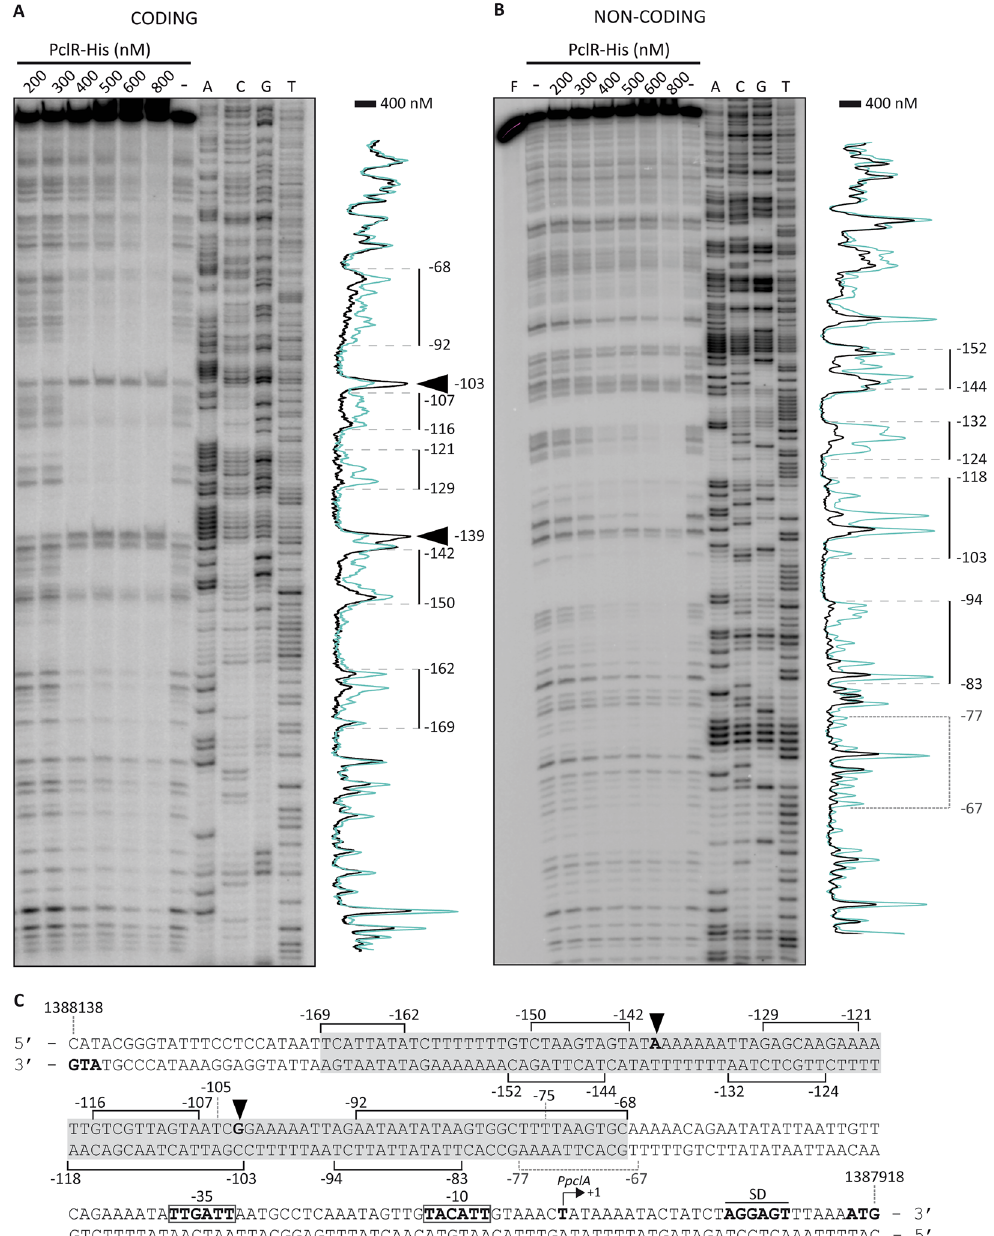
Figure 4. DNase I footprints of PclR-His-DNA complexes. (A) The 270-bp DNA fragment (coordinates 1,388,196 to 1,387,927) was 32 P-labelled at the 5 ′ end of the coding strand ( pclA gene) using the 32 P-labelled Dw 1404 oligonucleotide. (B) The 281-bp DNA fragment (coordinates 1,388,232 to 1,387,952) was 32 P-labelled at the 5 ′ end of the non-coding strand (relative to pclA ) using the 32 P-labelled Up 1404 -2 oligonucleotide. The labelled DNA (2 nM) was incubated with the indicated concentrations of PclR-His and then digested with DNase I. Non-digested DNA (F) and dideoxy-mediated chain termination sequencing reactions were run in the same gel (lanes A, C, G, T). In panel A, the sequence corresponds to the coding strand of the 270-bp DNA fragment ( 32 P-labelled Dw 1404 oligonucleotide). In panel B, the sequence corresponds to the non-coding strand of the 281-bp DNA fragment ( 32 P-labelled Up 1404 -2 oligonucleotide). Densitometer scans corresponding to DNA without PclR-His (blue line) and DNA with PclR-His (400 nM, black line) are shown. The protected regions are indicated with brackets. Arrowheads indicate positions that are slightly more sensitive to DNase I cleavage. The indicated positions are relative to the transcription start site of the pclA gene. (C) Nucleotide sequence of the region that spans coordinates 1,388,138 to 1,387,918 of the R6 chromosome. The − 35 and − 10 elements of the PpclA promoter are indicated. The transcription start site (+1 position), the putative Shine- Dalgarno sequence (SD), and the translation start codon (ATG) of the pclA gene are indicated. Brackets indicate regions protected against DNase I digestion. Black arrowheads indicate positions that are slightly more sensitive to DNase I cleavage. The grey box includes the site recognized by